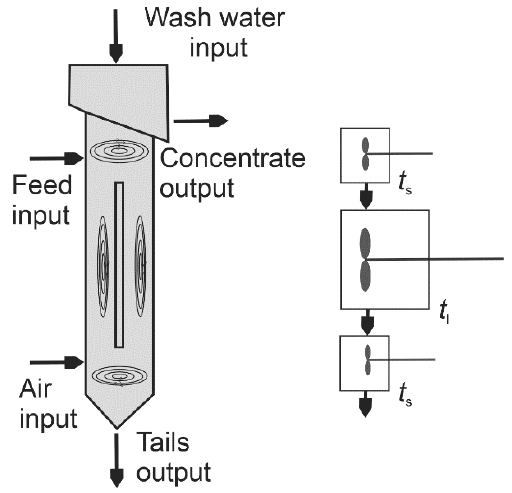
Figure 3. Model of mixing in flotation columns ( t s , t l denotes process characteristic time).